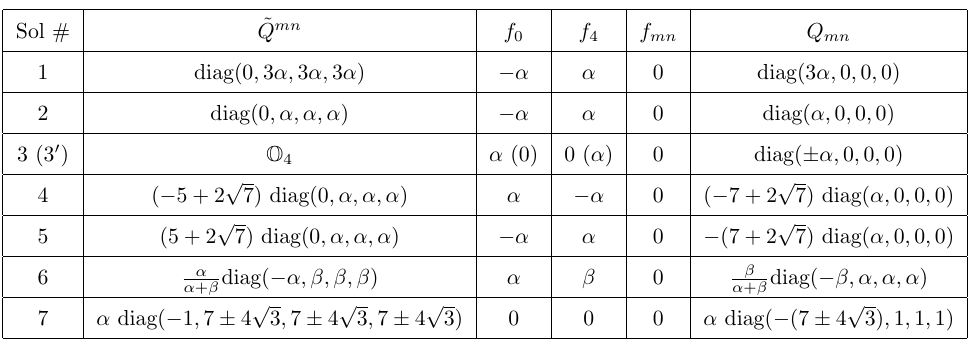
Table 12 . Critical points of the scalar potential induced by the compacti(cid:12)cation of mIIA with KKO5/KK5. Solution 1 is the supersymmetric AdS vacuum found in [40]. Sol #